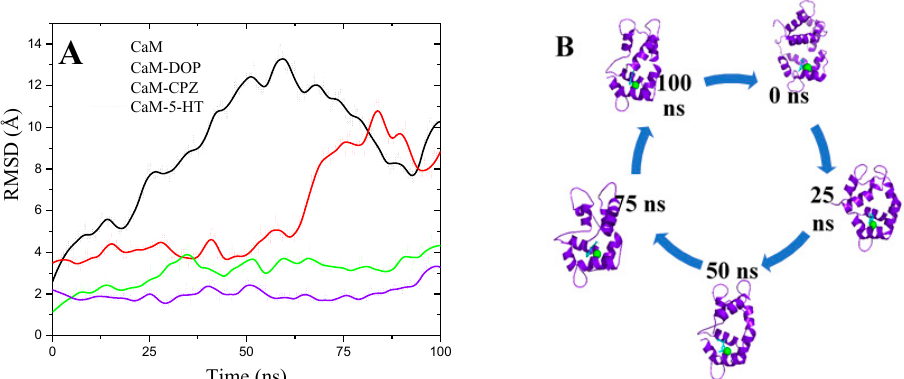
Figure 7. Analysis of 100 ns of molecular dynamics simulation. ( A ) The RMSD vs. time plot for 100 ns molecular dynamics simulation. ( B ) Structural models of fragments of the molecular dynamics of the CaM–5-HT complex.